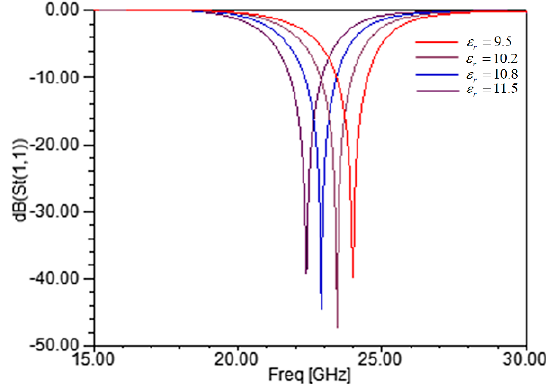
Figure 4. Reflection coefficient of the sensor with the permittivity increased by 20%.